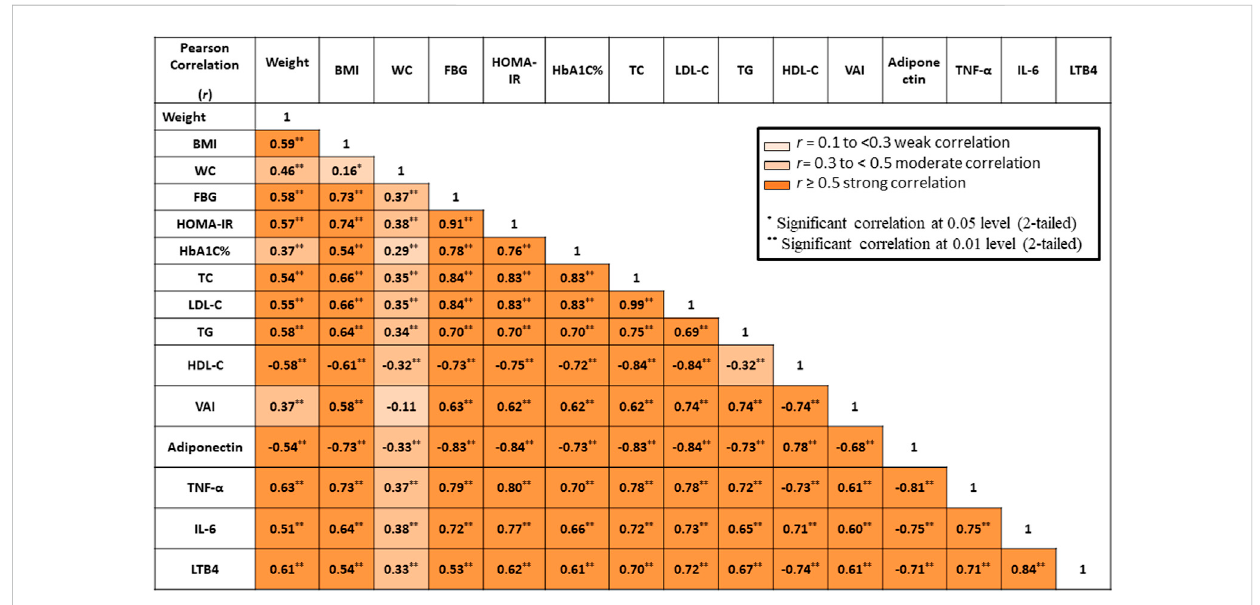
FIGURE 2 Correlation between all measured parameters. BMI, body mass index; WC, waist circumference; FBG, fasting blood glucose; FI, fasting insulin, HOMA-IR, homeostasis model assessment – insulin resistance; HbA1c, glycated hemoglobin; TC, total cholesterol; TG, triglyceride; HDL-C, high-density